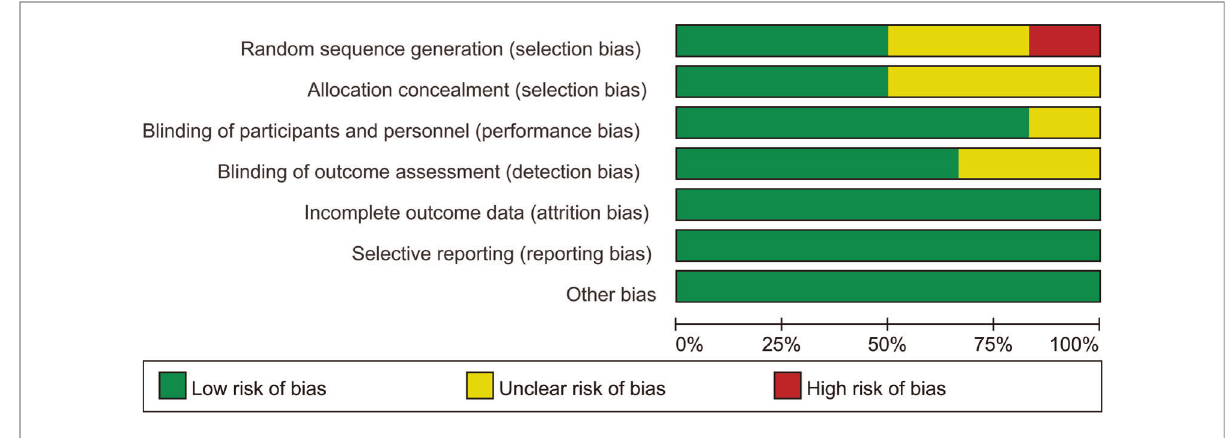
FIGURE 2 Quality evaluation results of included literature.